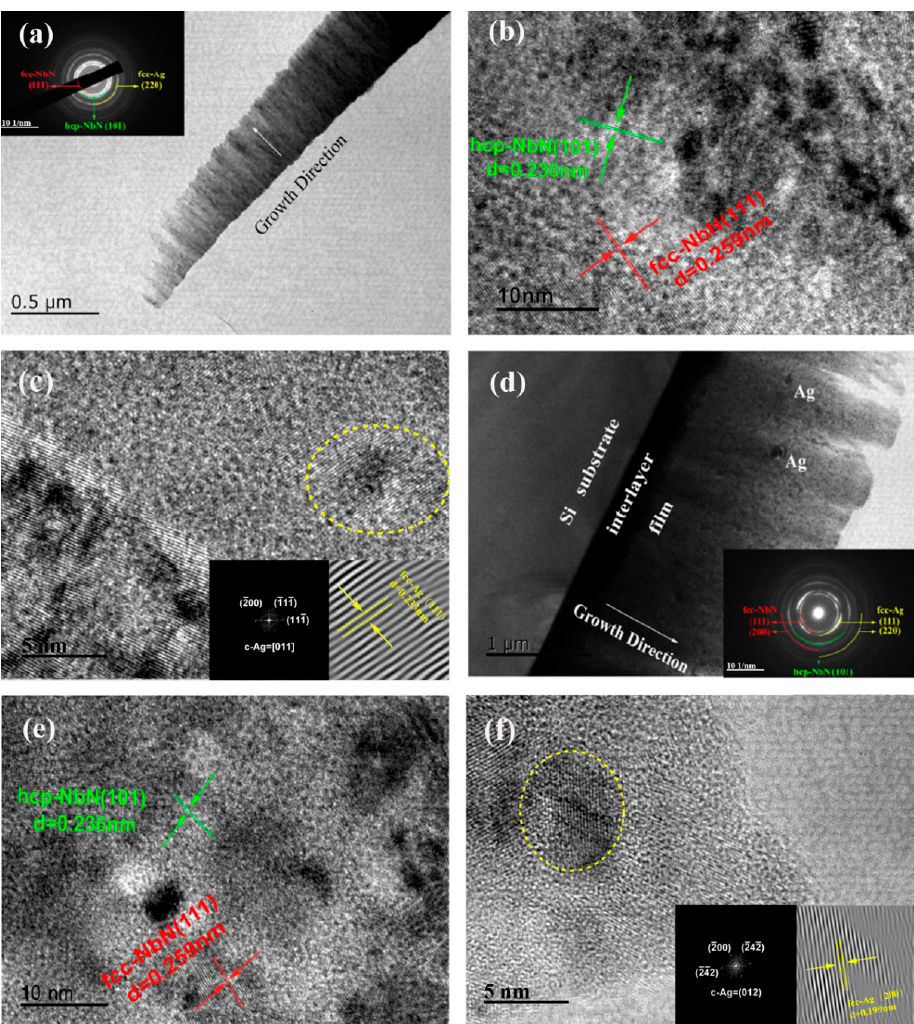
Figure 5. Transmission electron microscopy (TEM) and high resolution (HR)-TEM observations of NbCN-2.0 at.% Ag ( a – c ) and NbCN-12.9 at.% Ag ( d – f ) films. Inserts are the selected area electron diffraction (SAED) patterns for located areas.